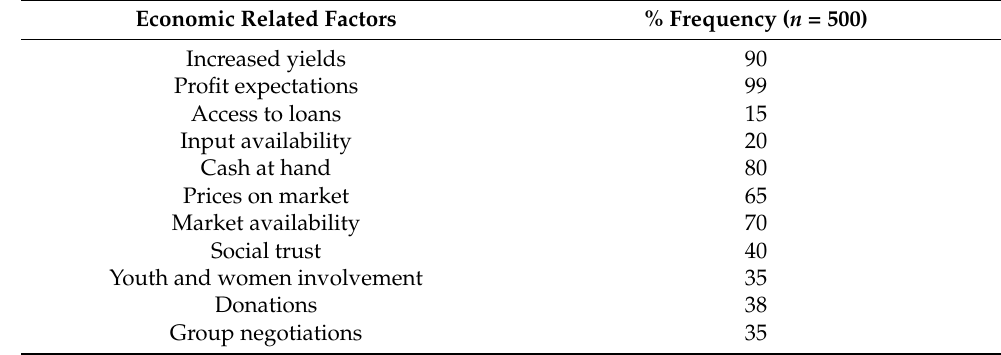
Table 5. Description of the distribution of the answers related to the economic aspects of adoption.